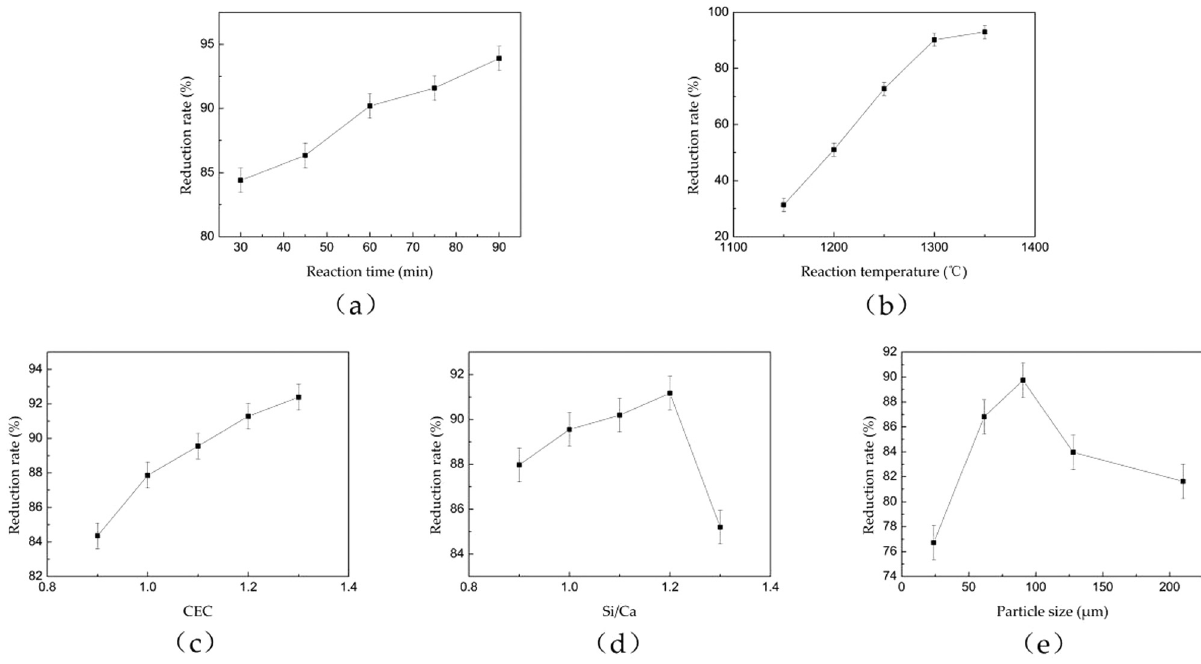
Figure 1: In fl uence of various factors on the reduction rate. ( a ) Fixed levels B ( 1,300°C ) , C ( 1.20 ) , D ( 1.20 ) , E ( 75 – 106 µm ) . ( b ) Fixed levels A ( 75 min ) , C ( 1.20 ) , D ( 1.20 ) , E ( 75 – 106 µm ) . ( c ) Fixed levels A ( 75 min ) , B ( 1,300°C ) , D ( 1.20 ) , E ( 75 – 106 µm ) . ( d ) Fixed levels A ( 75 min ) , B ( 1,300°C ) , C ( 1.20 ) , E ( 75 – 106 µm ) . ( e ) Fixed levels A ( 75 min ) , B ( 1,300°C ) , C ( 1.20 ) , D ( 1.20 ) .